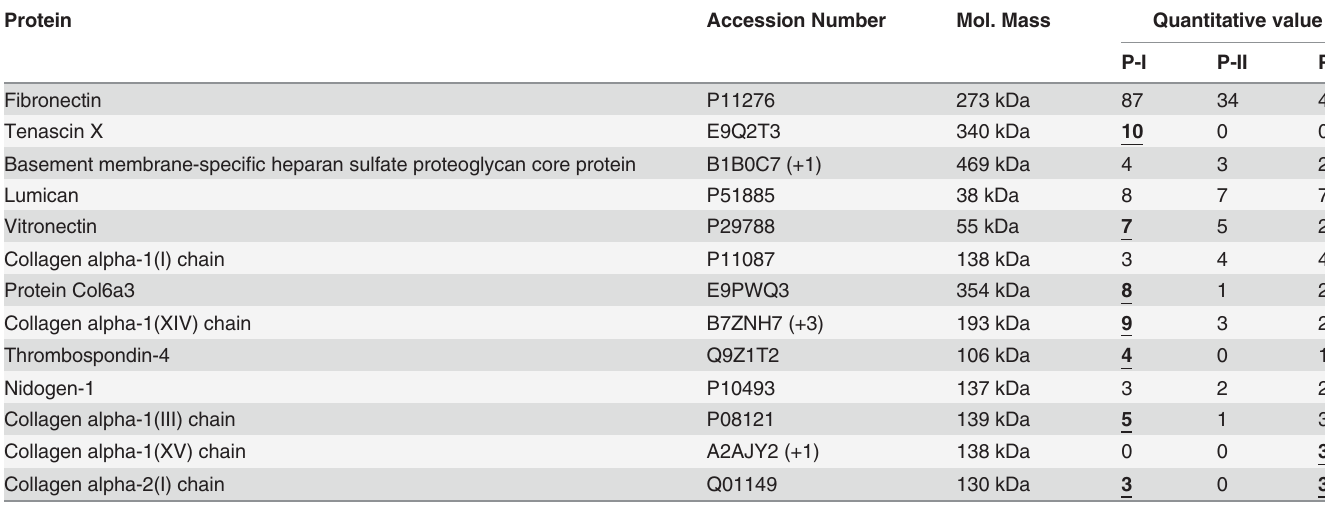
Values in bold and underlined correspond to proteins for which at least one SVMP induced an increment of at least three times as compared to another SVMP.